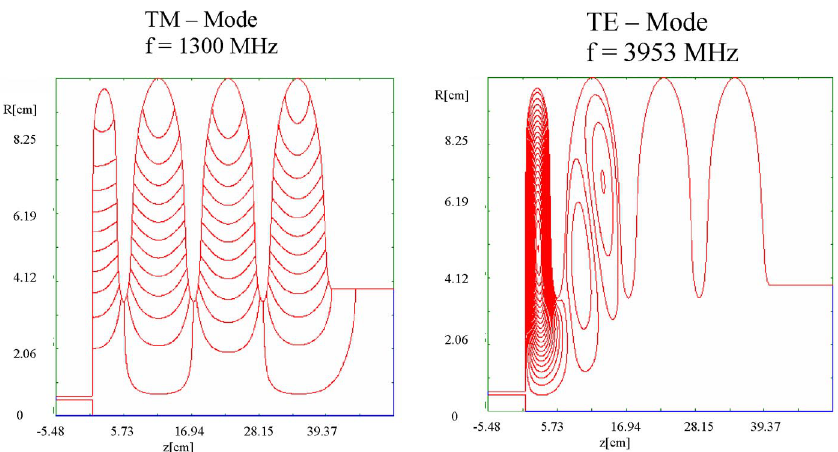
(cid:1) const ) and the TE mode ( rB ’ 010